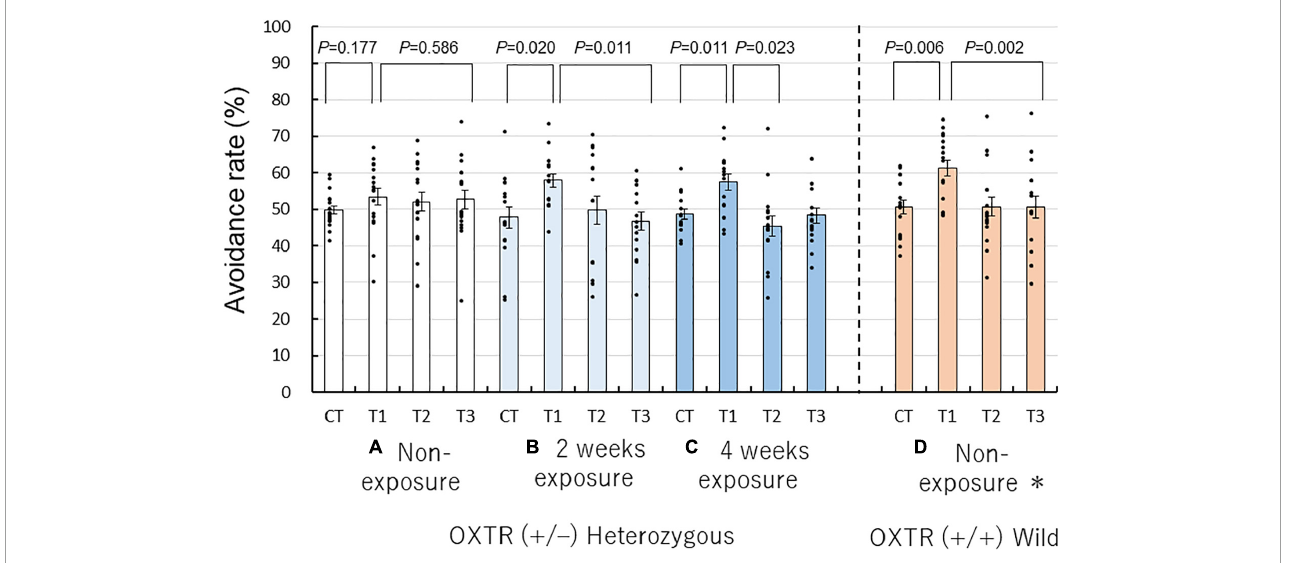
FIGURE3 Repeated coffee odor exposure-induced rescue of abnormal olfactory behaviors of heterozygous oxytocin receptor (OXTR) ( ± ) mice. Avoidance rates of non- (A) , 2-week (B) , 4-week exposures to coffee odor of heterozygous OXTR ( ± ) mice (C) , and non-exposure wild-type mice (D) ( n = 16) (Osada et al., 2018). Black dots describe individual data. Non-exposure heterozygous OXTR ( ± ) mice exhibited an abnormal avoidance behavior to the unpleasant odor on the first trial [trial 1 in (A) ], compared with non-exposure wild-type mice (D) . This abnormal avoidance behavior was rescued by 2 or 4 weeks of repeated exposure to coffee odor (C,D) . The statistical significance of the differences in the avoidance rates of the four groups was assessed using the Wilcoxon signed-rank test. Avoidance rates marked by the letter a are significantly different from those marked by the letter b ( P < 0.05).